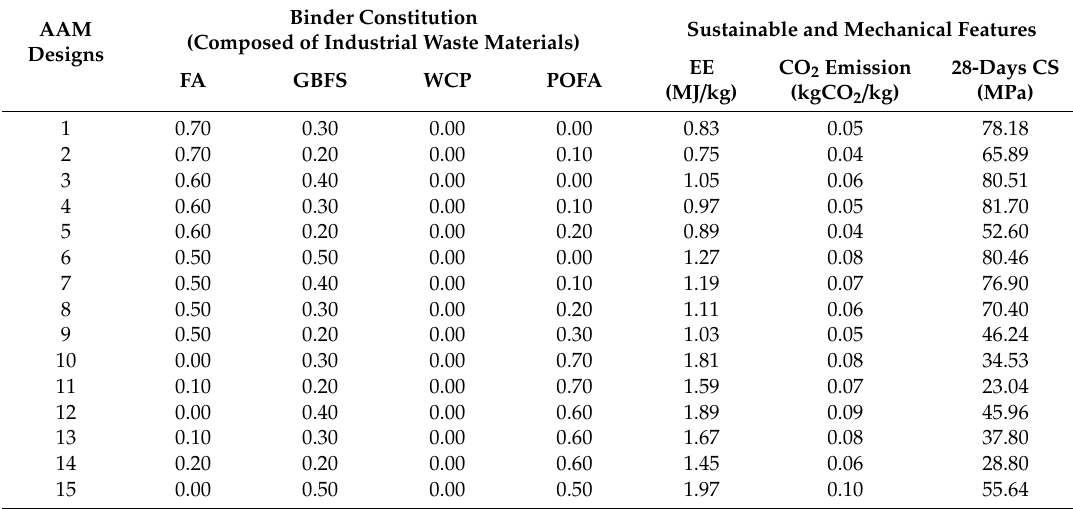
Table 7. Calculated EE and CO 2 emission for all the studied AAM